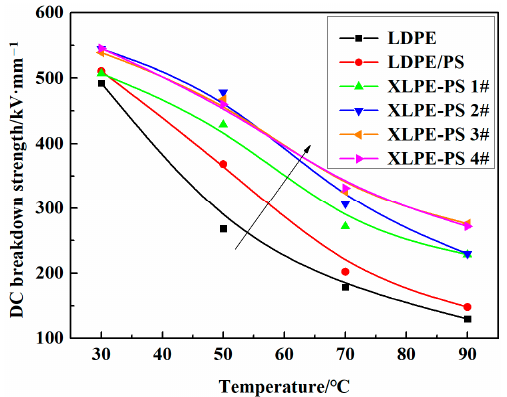
Figure 3. Temperature dependence of DC breakdown strength for samples.